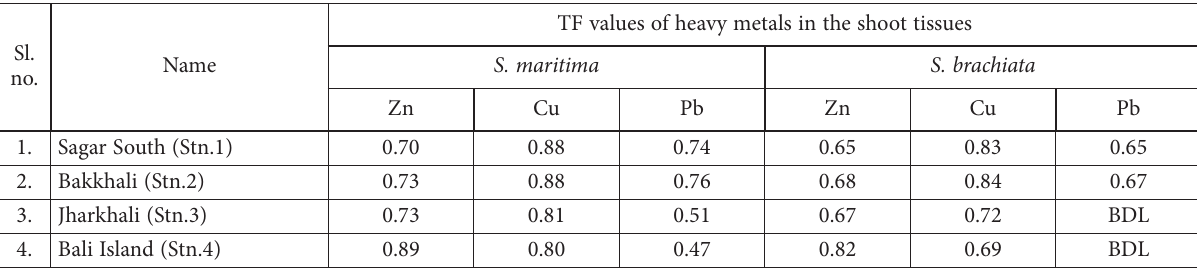
Table 2. Translocation factor (TF) values of heavy metals in the shoot tissues of S. maritima and S. brachiata